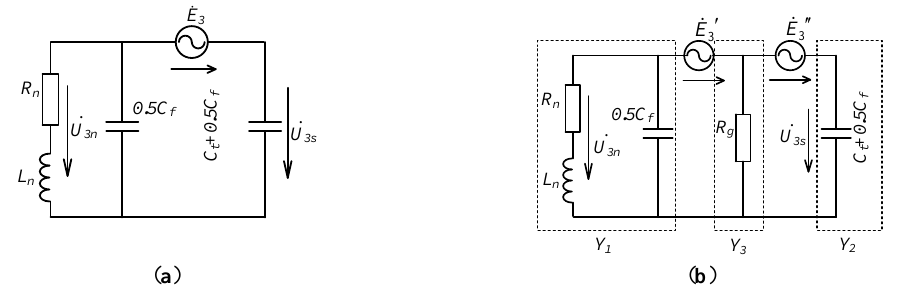
Figure 2. The third harmonic equivalent circuit of the generator. ( a ) Equivalent circuit under the normal operation; ( b ) equivalent circuit when the stator is grounded.